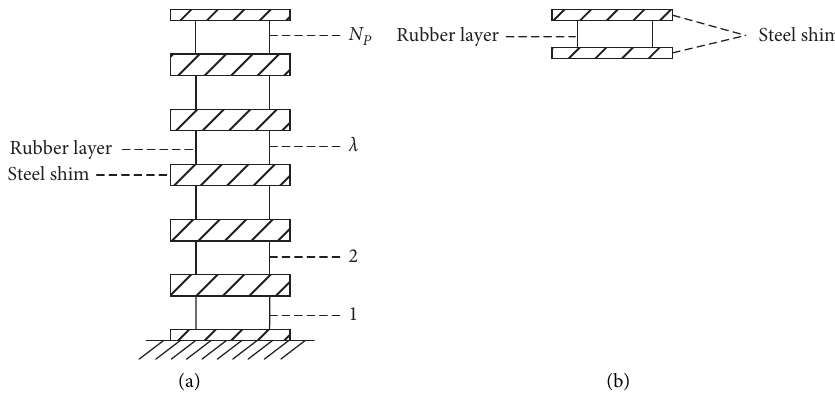
Figure 1: (a): The model of a laminated rubber bearing. (b): Rubber–steel cell.